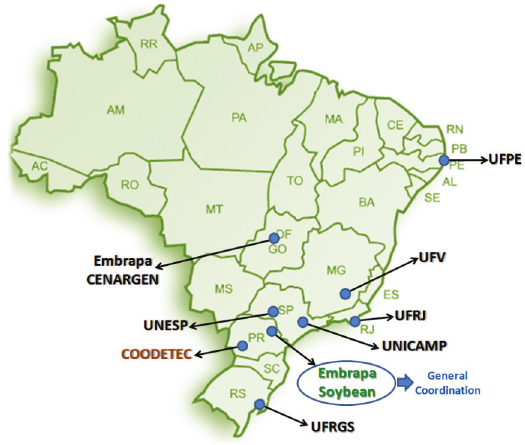
Figure 1 - The members of the GENOSOJA consortium and their geo- graphic distribution in Brazil, including nine institutions: Embrapa Soja (Londrina, Paraná), Embrapa Recursos Genéticos e Biotecnologia (CE- NARGEN, Brasília, Federal District), Universidade Estadual de Campi- nas (UNICAMP, Campinas, São Paulo), Universidade Estadual Paulista Júlio de Mesquita Filho (UNESP, Botucatu, São Paulo), Universidade Federal de Pernambuco (UFPE, Recife, Pernambuco), Universidade Fed- eral do Rio Grande do Sul (UFRGS, Porto Alegre, Rio Grande do Sul), Universidade Federal de Viçosa (UFV, Viçosa, Minas Gerais) and COODETEC (Cooperativa Central de Pesquisa Agrícola, Tecnologia da Nossa Terra), a representative of the private initiative.